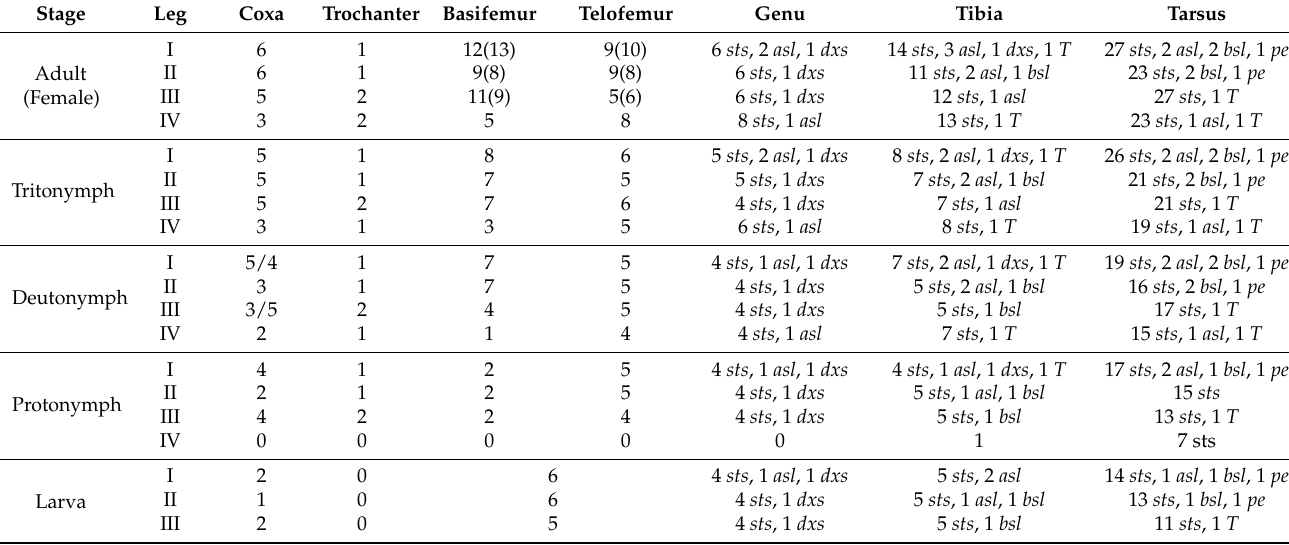
Table 2. Changes of leg chaetotaxy in different stages of Bdella muscorum .